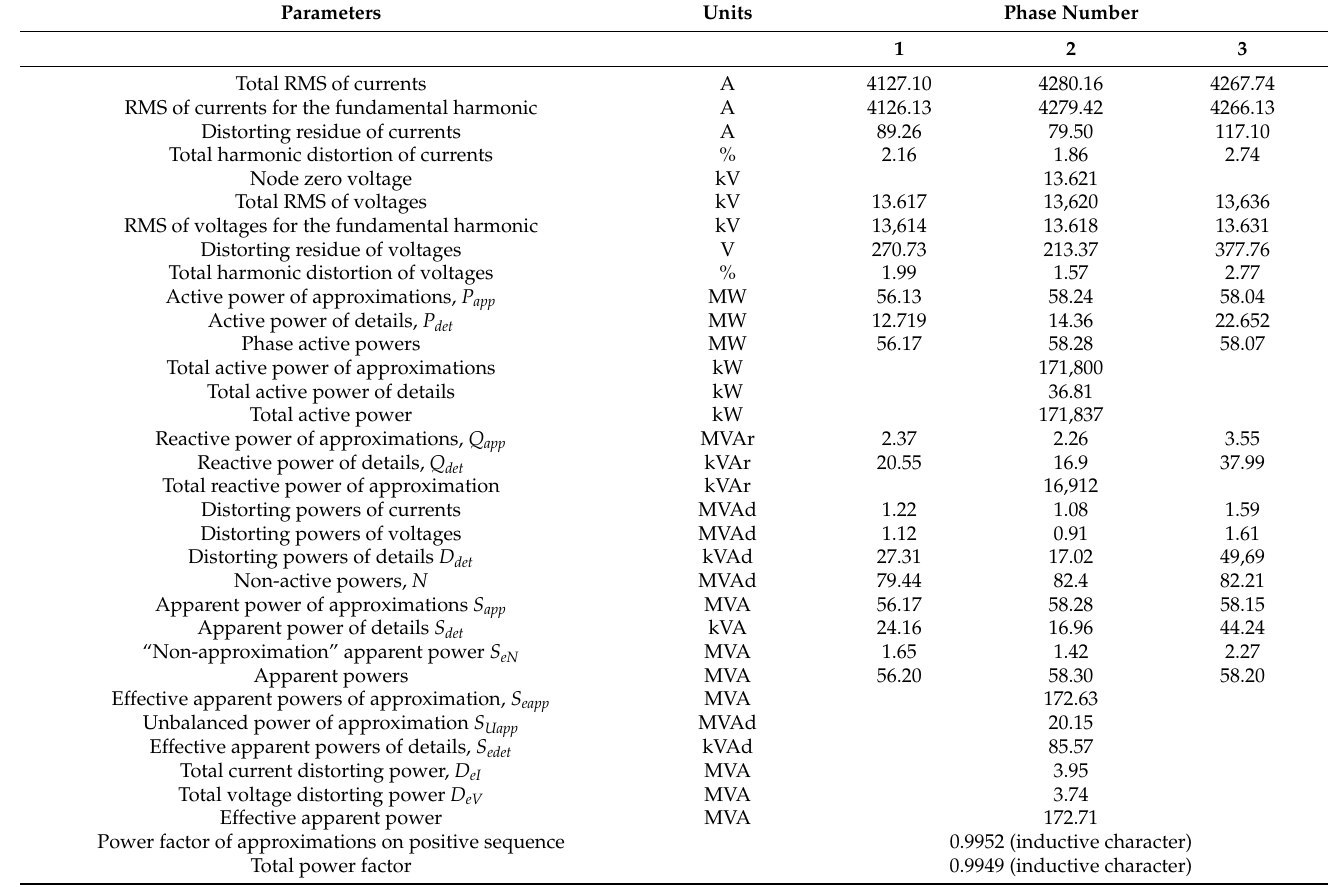
Table 8. Power quality indices, the powers and power factor using DWT and the third theory.